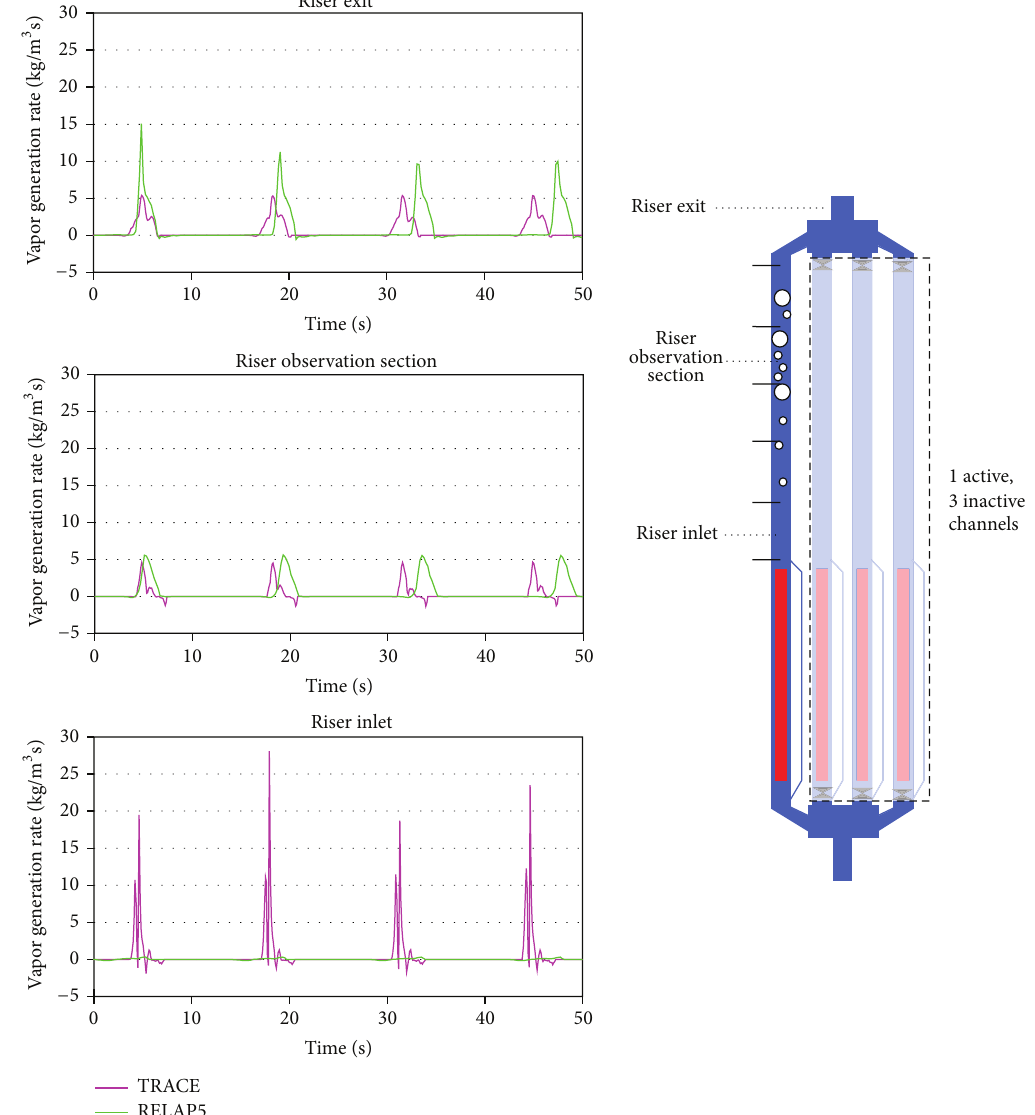
Figure 10: Test I-2: vapor generation rate in the